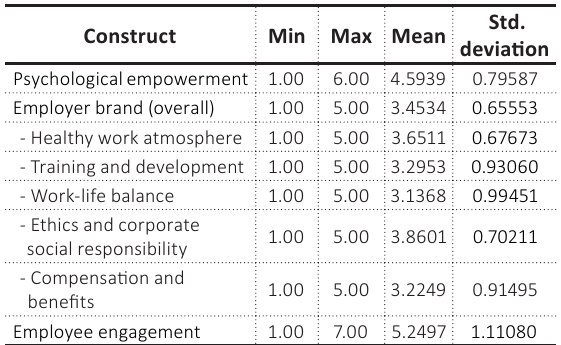
Table 2. Descriptive statistics